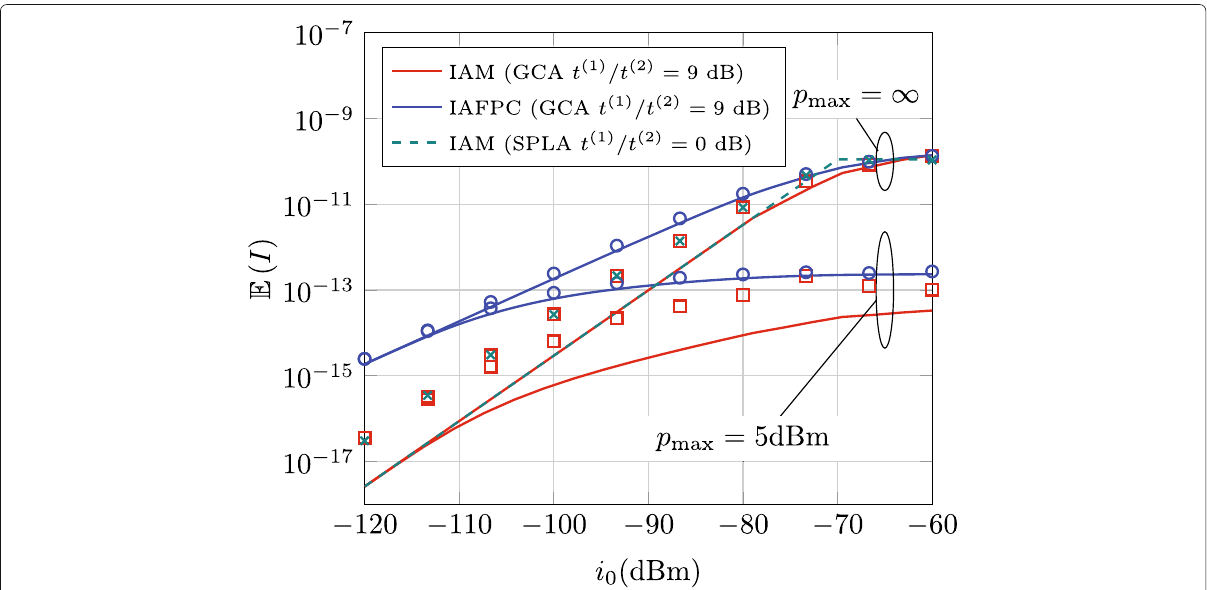
Fig. 3 Mean of the interference versus i 0 for IAM and IAFPC methods with (cid:5) = 1, p max → ∞ , and p max = 5 dBm